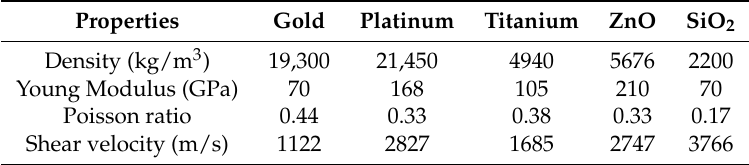
Table 2. Mechanical and acoustical properties of the guiding